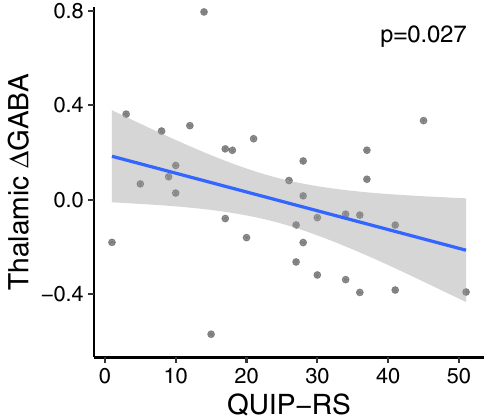
Fig. 2 Relationship between GABAergic response to dopamine agonist therapy and impulsivity. Partial correlation between the pharmacological effect of dopamine agonist (DAA) on thalamic GABA ( Δ GABA) and the Questionnaire for Impulsive-Compulsive Disorders in Parkinson ’ s Disease-Rating Scale (QUIP-RS) score. Δ GABA values are adjusted for age and DAA dosage. The QUIP-RS score is a clinical measure of ICB symptom severity, in which higher values represent the predilection towards reward-based behaviors. The regression analysis showed that higher QUIP-RS scores were associated with lower thalamic Δ GABA ( p = 0.027), while adjusting for age and DAA